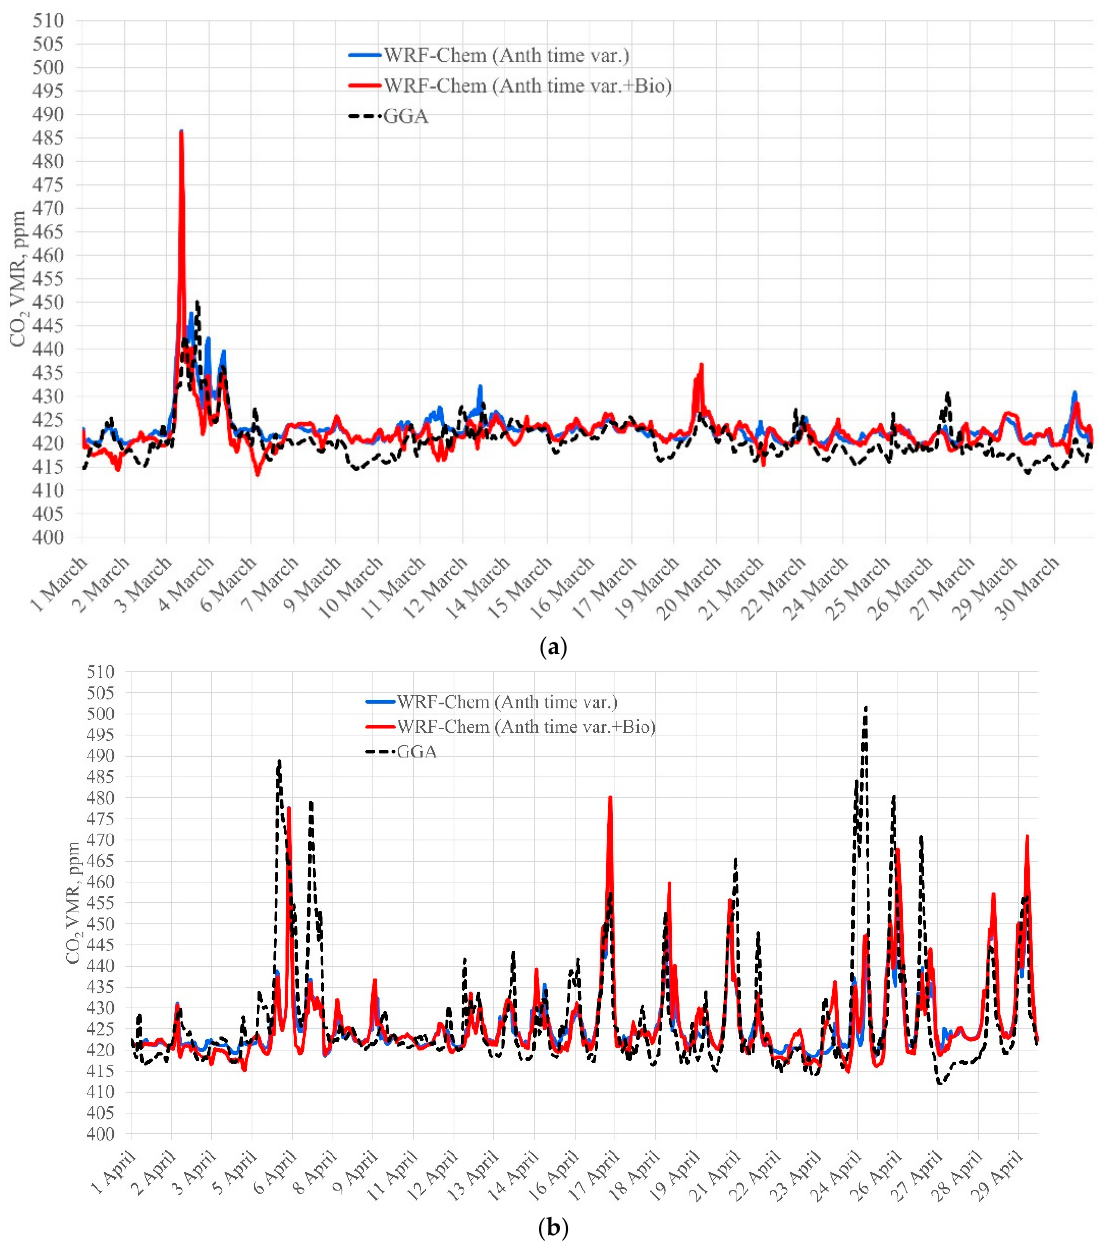
Figure 9. Temporal variation (1 h) in surface atmospheric CO 2 mixing ratio according to the WRF-Chem runs with time- varying biogenic and anthropogenic fluxes and only with time-varying anthropogenic emissions and in situ observations in Peterhof in March ( a ) and April ( b ) 2019; Anth: anthropogenic emissions; Bio: biogenic fluxes; time var.: time-varying.